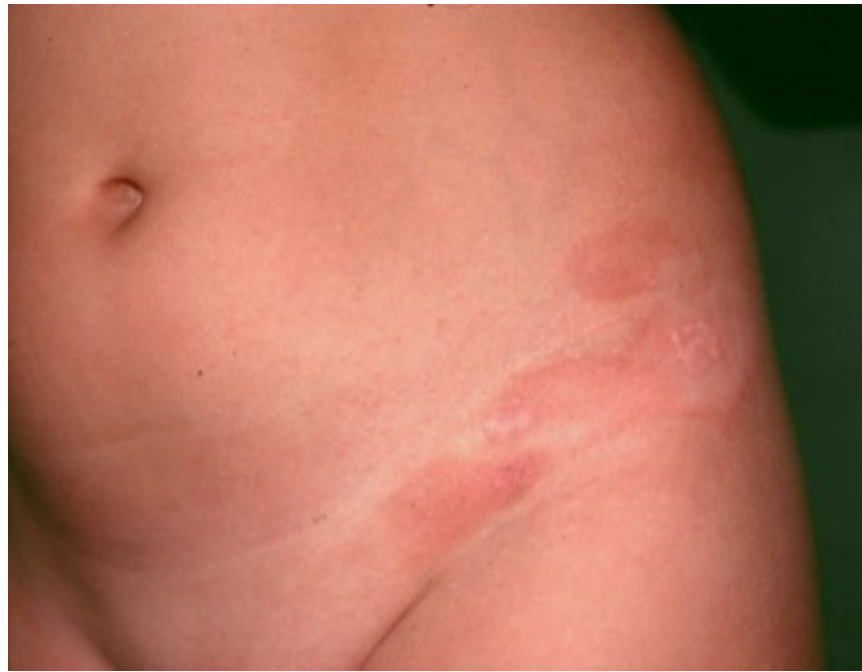
Figure 1. Early lesions consist of erythematous macules and vaguely annular patches with a slightly raised border and irregular zones of central clearing on the groin and